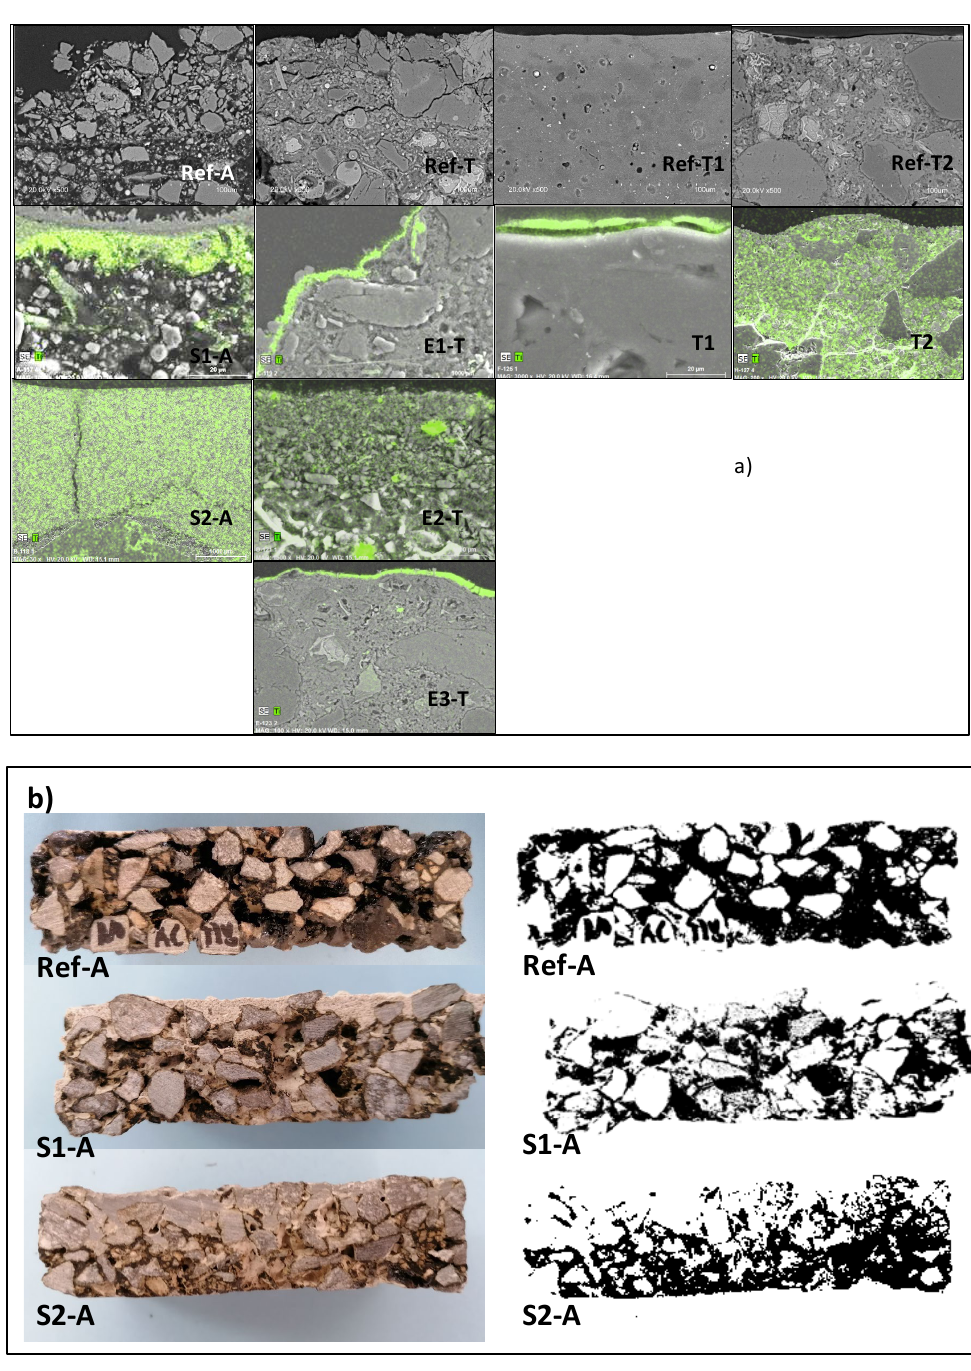
Figure 2. ( a ) BSE images for the reference and photocatalytic materials (with the corresponding elemental mapping images for Ti in green). Images for E1-A, E2-A and E3-A are not given as no Ti could be detected in the transversal cut. ( b ) Pictures of the profile reached by the slurries into the open asphalt.